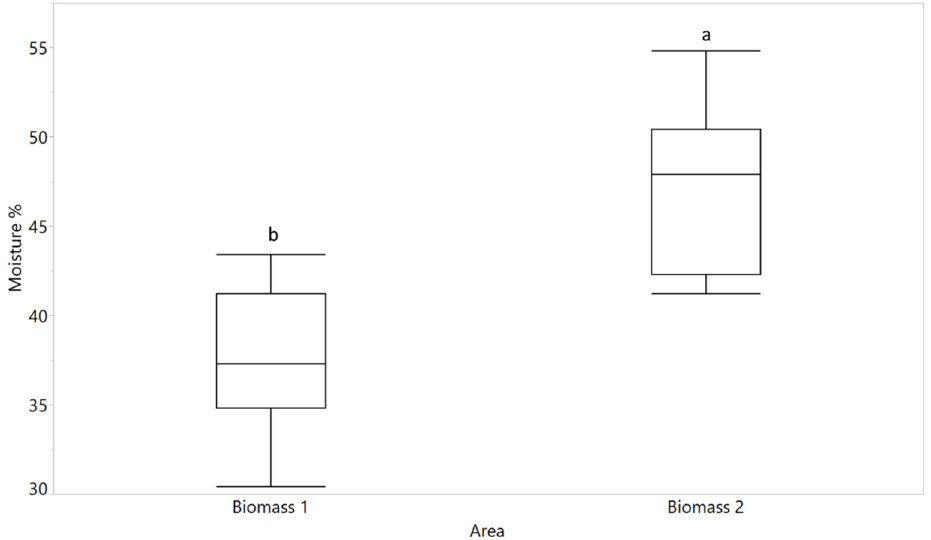
Figure 2. Moisture boxplot in the two cultivated areas. The letters indicate a significant difference